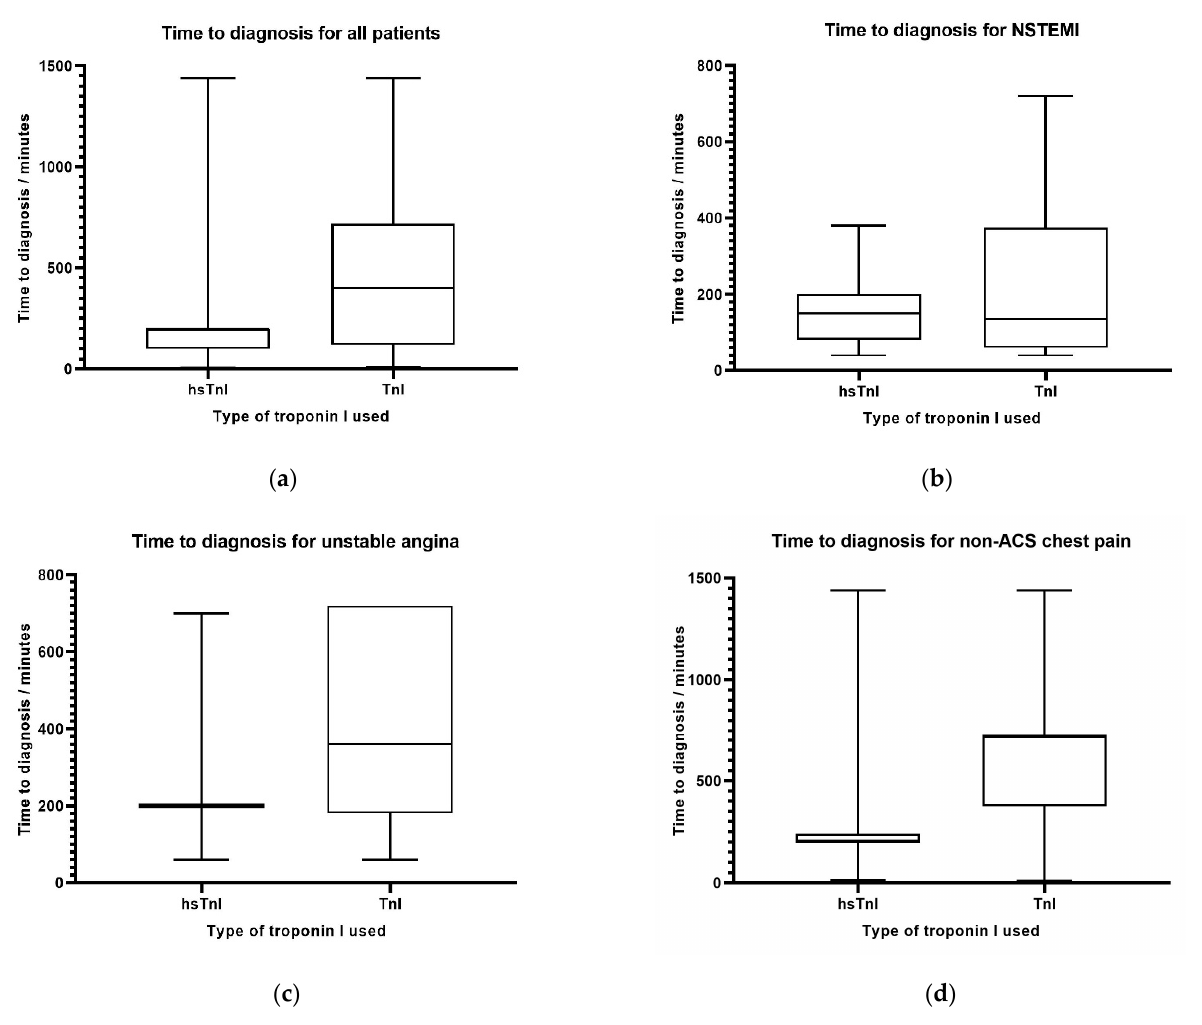
Figure 1. The difference in median time to diagnosis between hsTnI and cTnI for various final diagnoses: ( a ) time to diagnosis for all patients, ( b ) time to diagnosis for NSTEMI, ( c ) time to diagnosis for unstable angina, and ( d ) time to diagnosis for non-ACS chest pain.